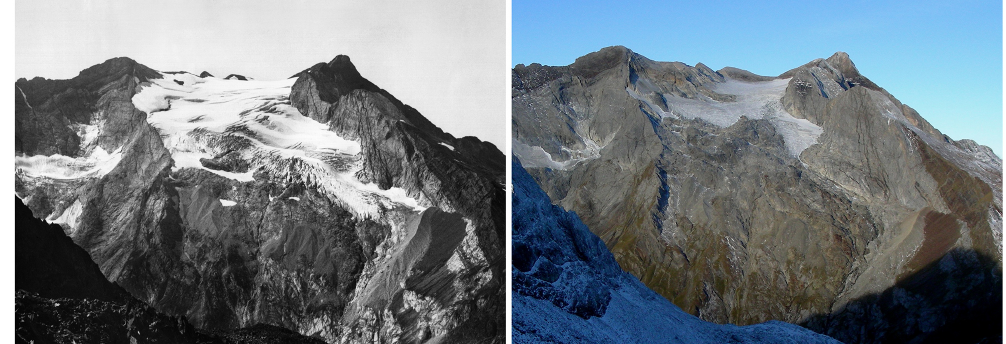
Figure 2. Photo comparison of Ossoue Glacier (Vignemale Massif): left, 1911 (L. Gaurier); right, 2011 (P. René).